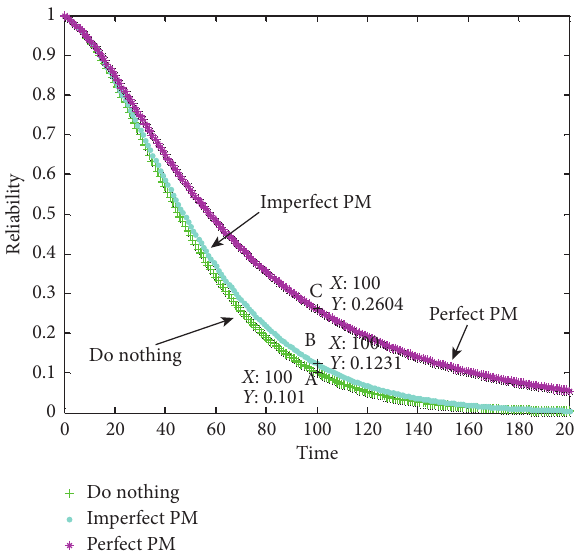
Figure 10: The changing trends of R ( t ) on three types of PM